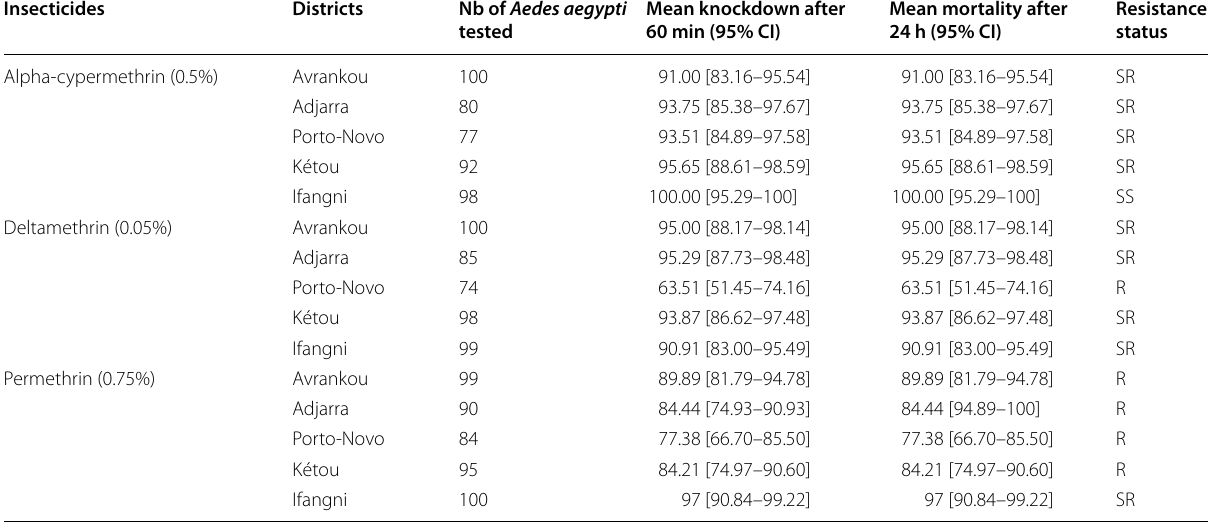
Nb number, R resistance, SR suspected resistance, S